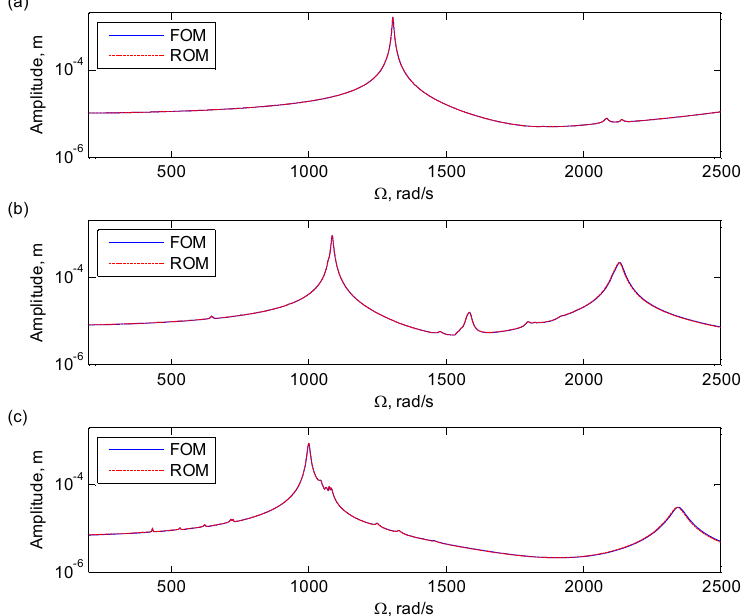
Figure 6. Comparisons of the forced responses of the excitation nodes of the assembly with blade mistuning between the full-order model and reduced-order model with excitations of ( a ) 1EO, ( b ) 2EO, and ( c ) 3EO. The full- and reduced-order models contain 103,563 and 7179 degrees of freedom (DOFs), respectively.